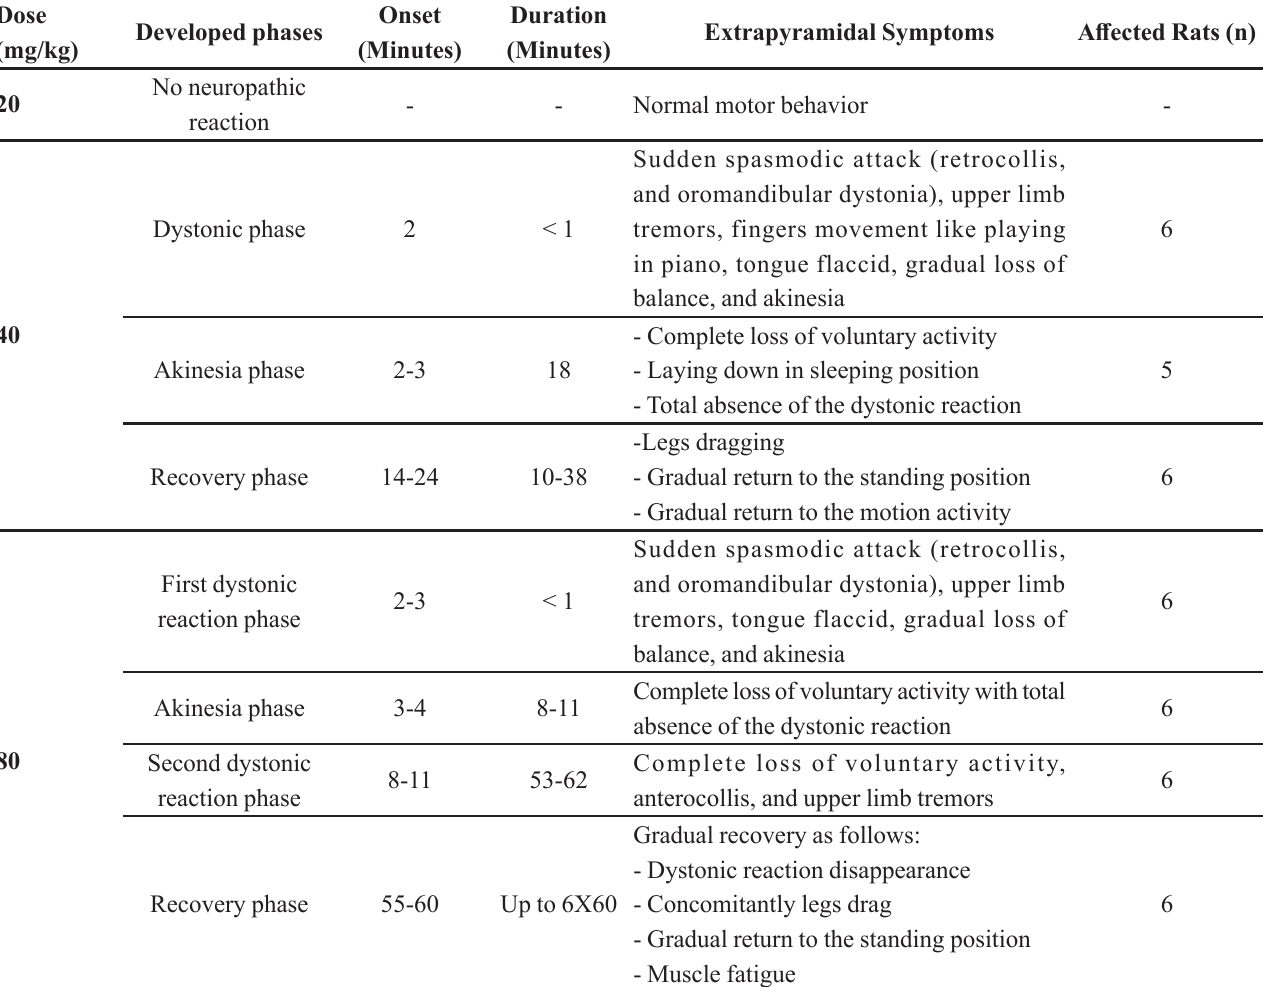
TABLE IV - The extrapyramidal symptoms induced by intraperitoneal administrated MFA-DDC liposomes